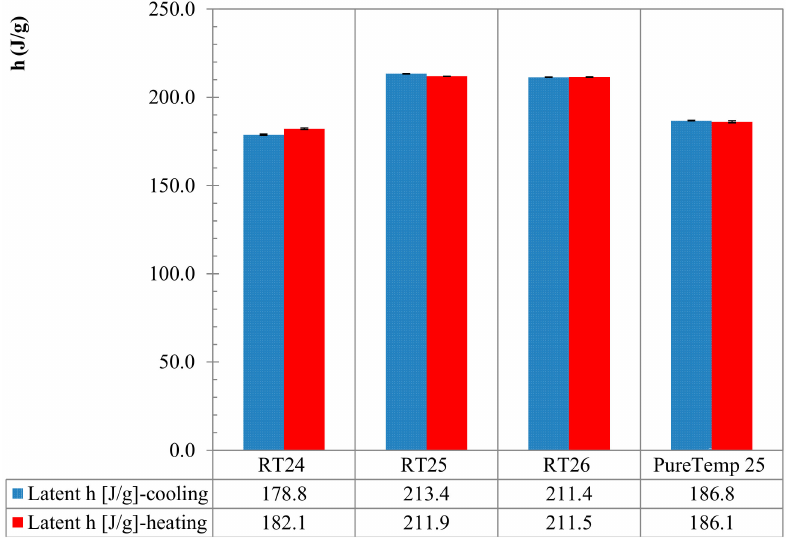
Figure 13. Latent absorbed / released h [J / g] during melting / crystallization following the dynamic DSC